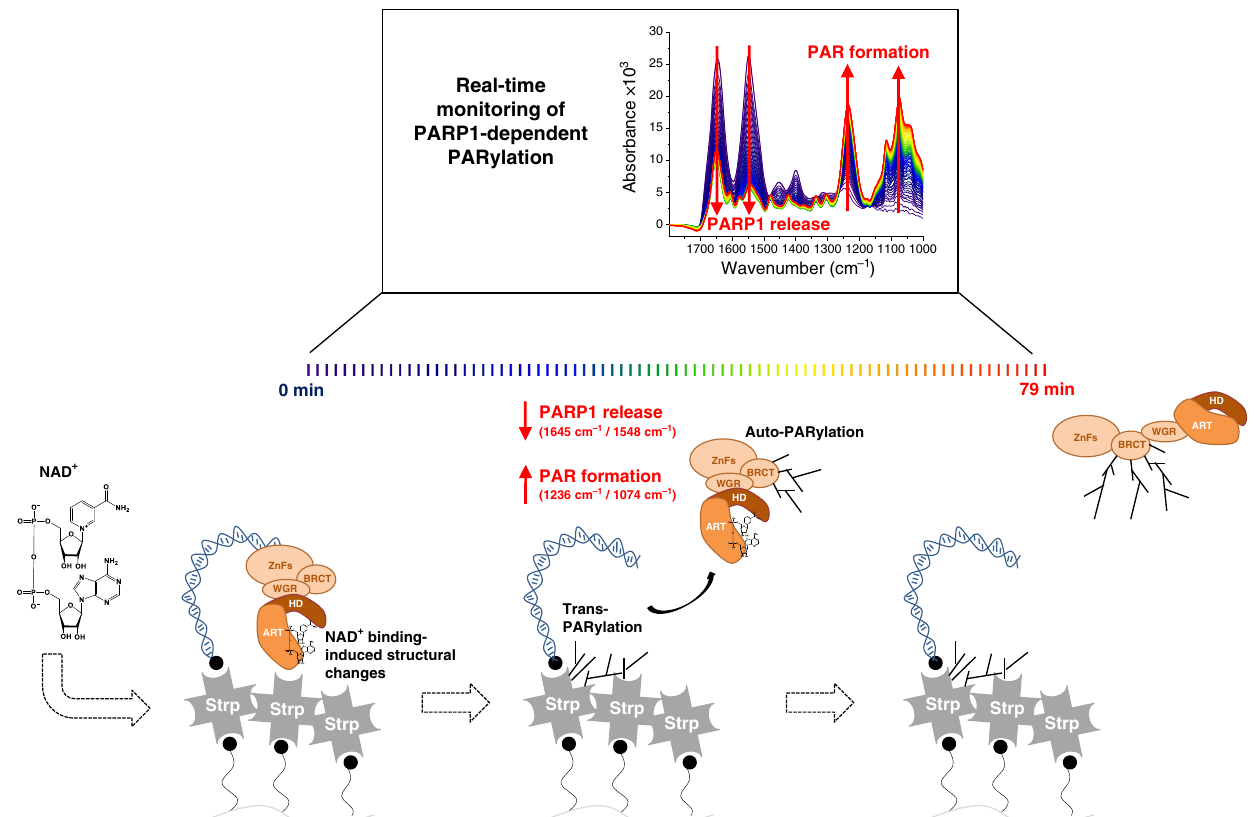
Fig. 7 Mechanistic model of PARP1-dependent PARylation derived by time-resolved ATR-FTIR spectroscopy. Directly after NAD + addition binding of NAD + to the catalytic centre induces distinct structural changes of PARP1. This is followed by the release of PARP1 from DNA, which is re fl ected by a decrease of PARP1 signal intensity (amide I (1645 cm − 1 ) and amide II (1548 cm − 1 ) bands), and the simultaneous formation of PAR, which is re fl ected by an increase of PAR signal intensities [anti-symmetric (1236 cm − 1 ) and symmetric (1074 cm − 1 ) phosphate vibrations]. The observed formation of PAR is mainly due to trans-PARylation of streptavidin, which is mediated by the close proximity of streptavidin to the DNA strand